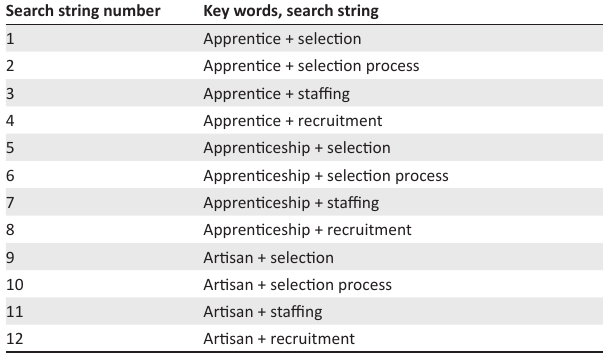
FIGURE 1: Steps in the systematic literature review. TABLE 1: Search strings used in the systematic literature review. Search string number